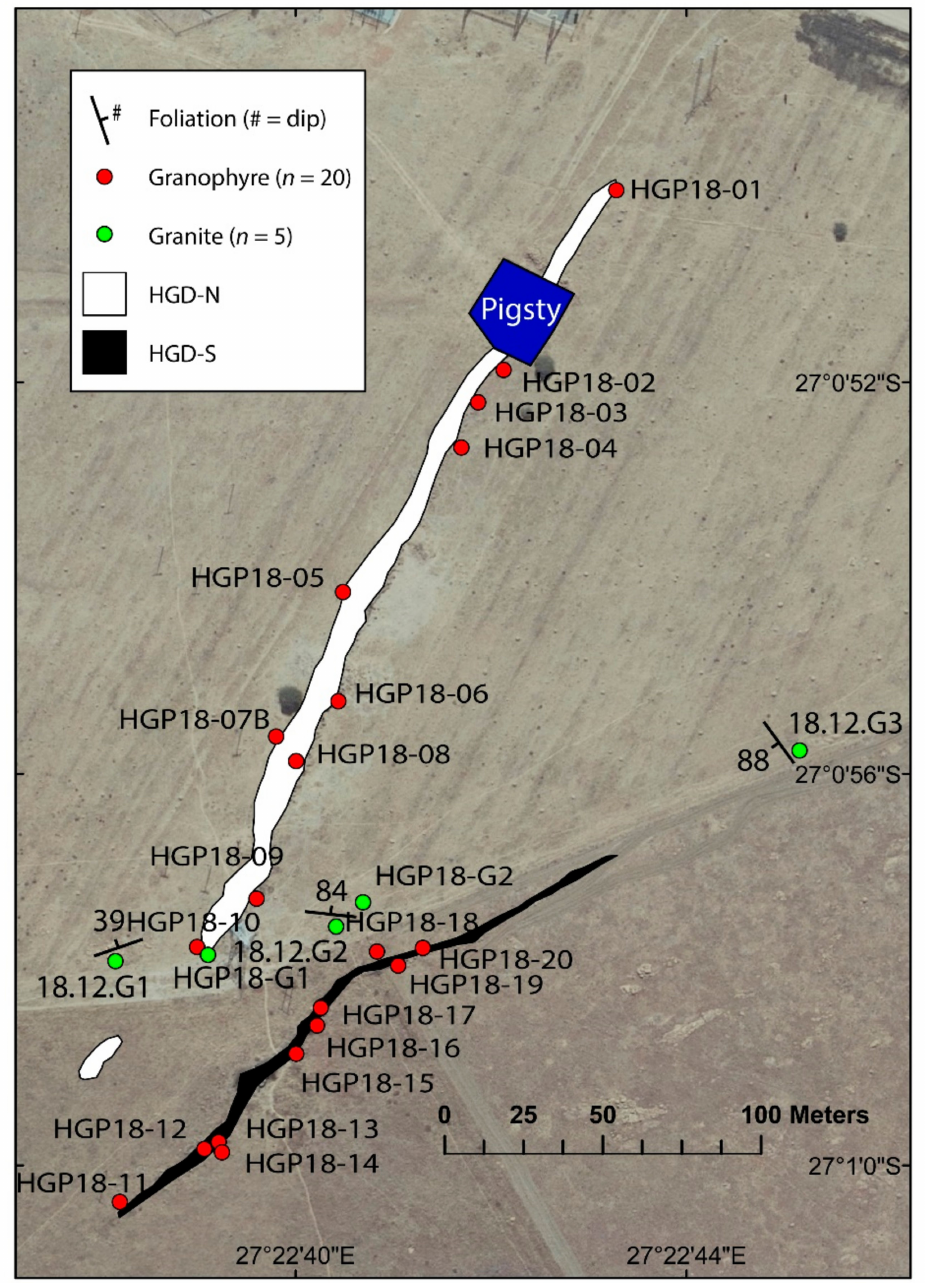
Figure 2. An aerial photograph with sampling locations and foliation directions of the Holfontein Granophyre Dyke (HGD) and the surrounding granite. Continuous patches of granophyre are indicated by white (HGD north (HGD-N)) and black (HGD south (HGD-S)) polygons. The two dike segments have textural distinctions in the field [13]. HGD-N contains on average < 10 vol.% of clasts, its matrix has spherulitic textures, and it does not contain pegmatitic veins. By contrast, HGD-S has inhomogeneously distributed clasts, with a 1 m wide section at the north margin of the dike containing > 10 vol.% clasts, but the remainder of the dike contains < 10 vol.% clasts. HGD-S does not have a spherulitic texture in the matrix and contains pegmatitic veins [13]. The pegmatitic veins are oriented subparallel to the margins of the dike segment, vary in thickness between 4 and 20 cm, and have the same proportion of lithic clasts as the hosting portions of granophyre